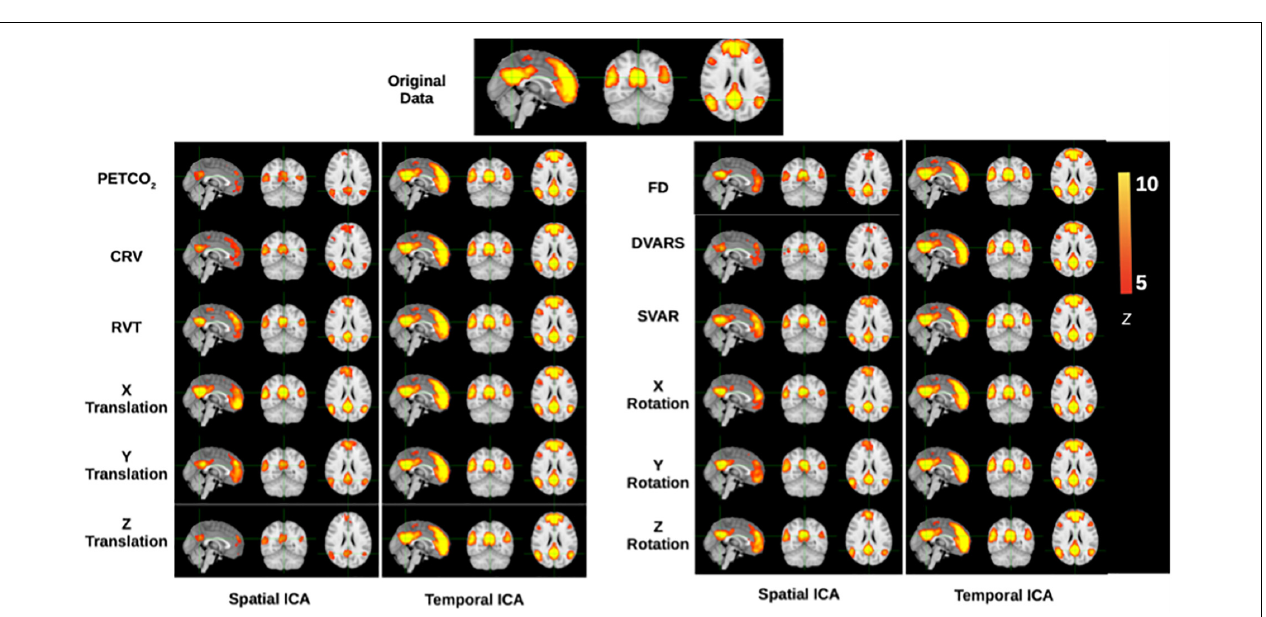
diverse noise sources in the low-frequency